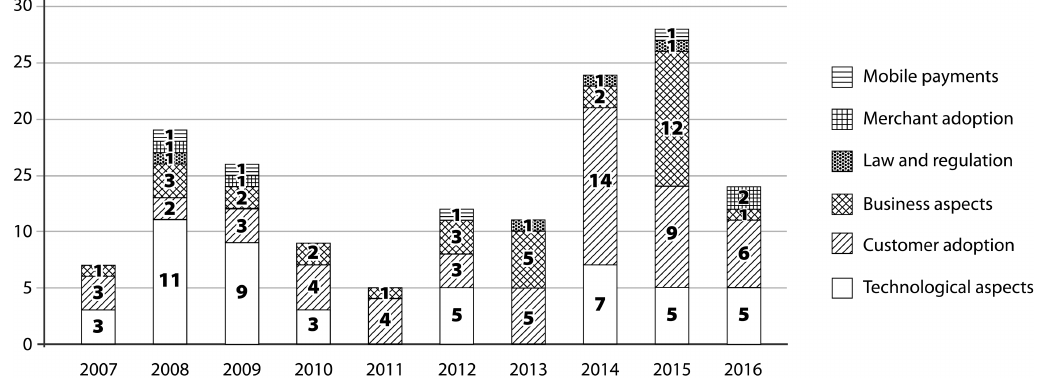
Fig. 3. Distribution of research themes by years.